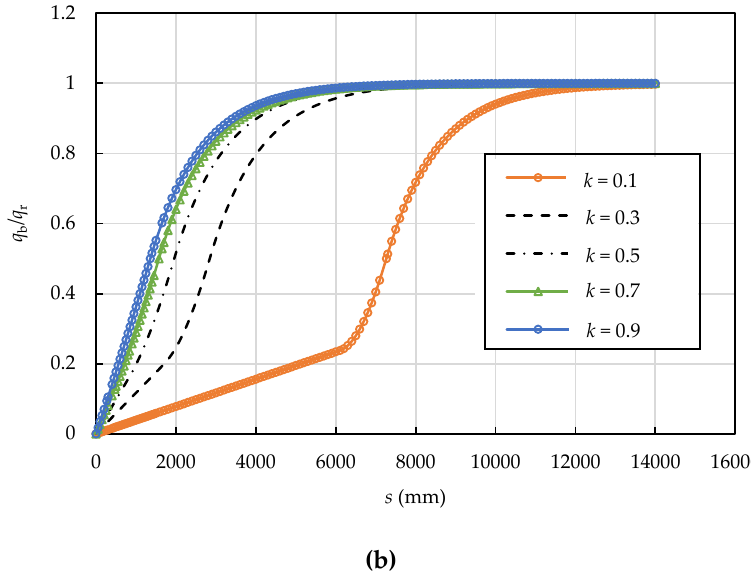
Figure 14. Effect of residual interfacial shear strength factor on the ( a ) interfacial shear and ( b ) normal stress distributions ( τ f = 0.62 MPa, δ 1 = 3.0 mm, and δ f = 6.6 mm).